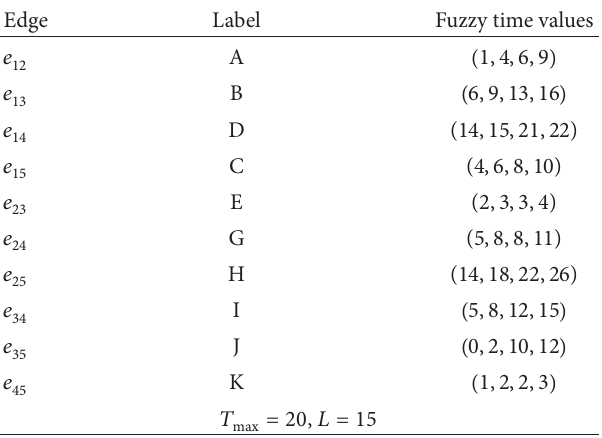
Figure 3: Fuzzy decision sets 𝑍 and 𝑍 ∗ .